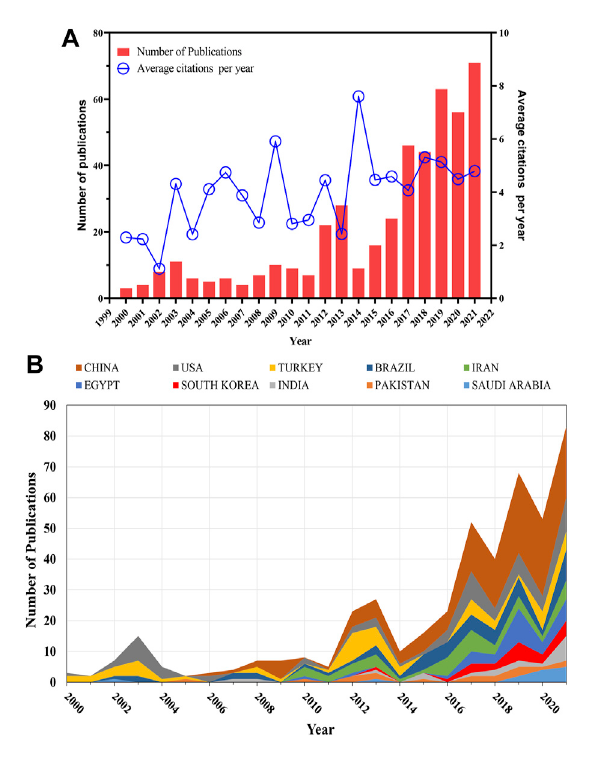
FIGURE 2 Trends in annual publications on heat stress in poultry. (A) Annual number of publications and average citation of articles. (B) Annual publication trends from top productive